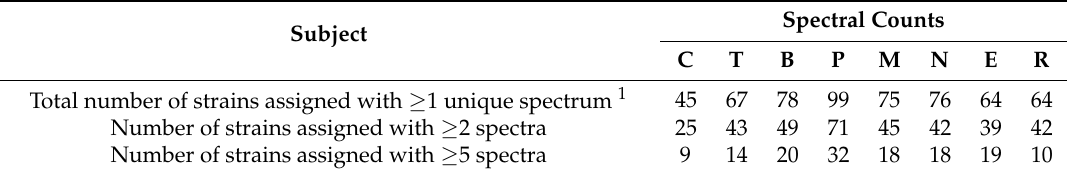
Table 2. Number of strain–level assignments by metaproteomics in each infant. These numbers are based on assignments of each MS/MS (tandem mass spectrometry) fragmentation spectrum to a peptide sequence and the assignment of that sequence uniquely to a particular bacterial strain.